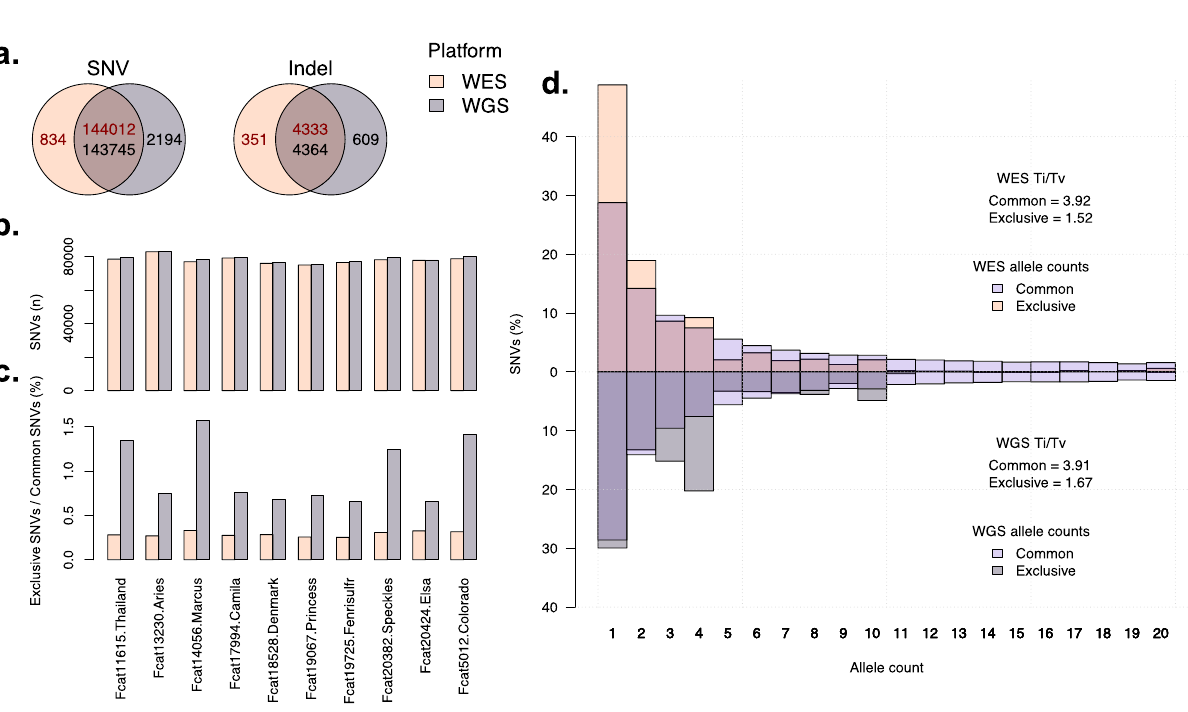
Figure 2. Variant calling statistics for 10 cats sequenced on both platforms. ( a ) Venn diagrams showing the number of exclusive and common variants per platform. Dark red text indicates the number of variants found in WES and black text indicates the number of variants found in WGS. The reason the number of common variants differ between platforms is because common variants were identified prior to filtering. ( b ) The number of SNPs found in each sample in both platforms. ( c ) The percentage of SNPs found as exclusive to each sample for each platform. The first, third, eighth, and tenth samples are males. All other samples are female. ( d ) Allele count distribution for common and exclusive SNPs in both platforms. WES SNPs are shown on top and WGS SNPs are shown upside down on the bottom. In addition, the Ti/Tv ratio for sets of SNPs is also